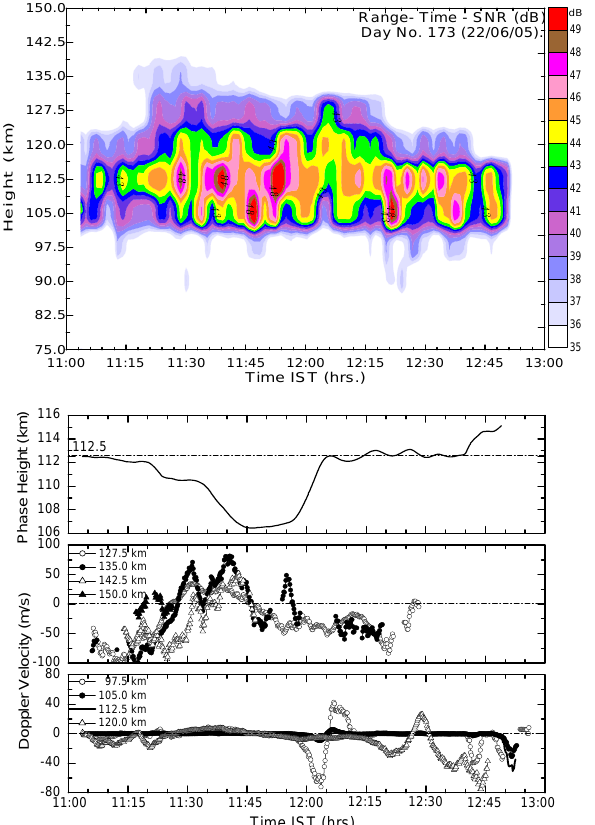
Fig. 3. Same as Fig. 2 except for the Day no. 145, 2005 (25 May